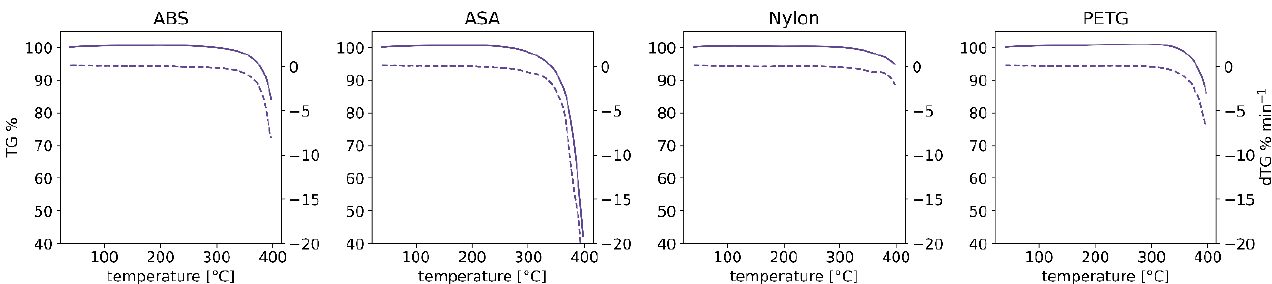
Figure 9. Results of the thermogravimetric analysis of the four FFF filaments.